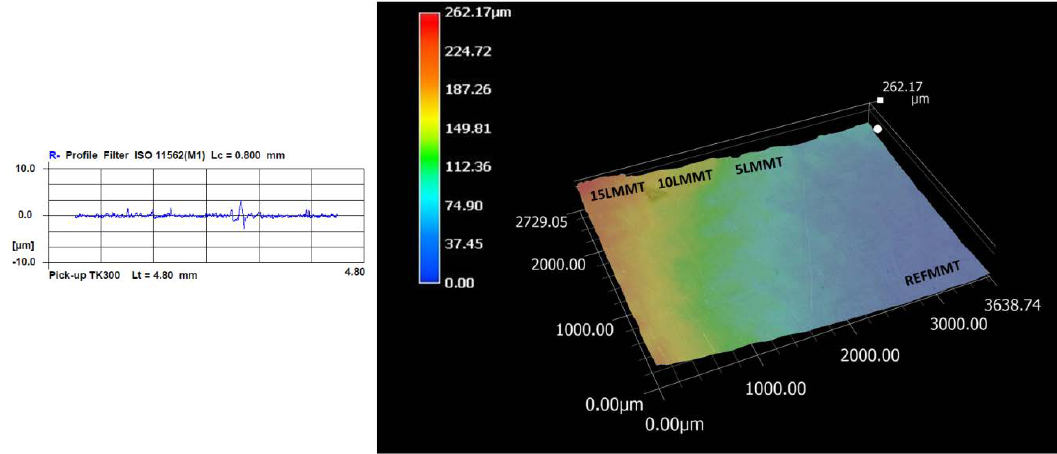
Figure 11. Two-dimensional roughness profile ( left ) and the 3D surface structure ( right ) for the sample 15LMMT.